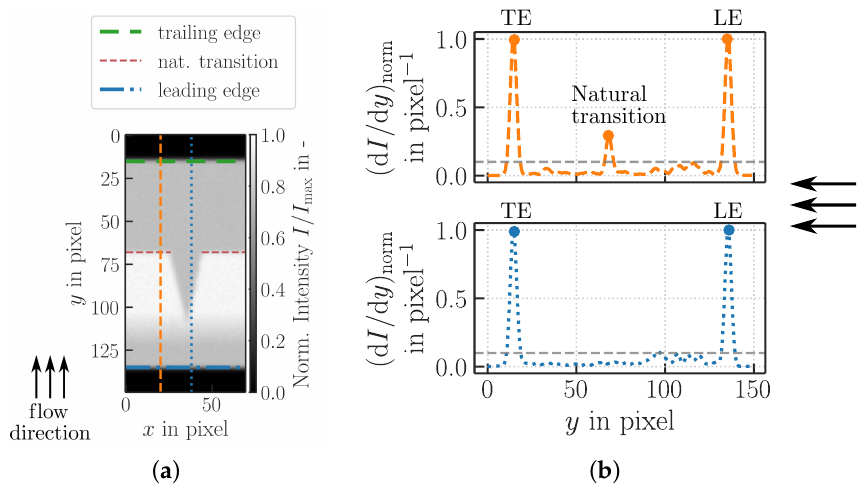
Figure 2. Simulated thermogram ( a ) and normalized gradient ( b ) for two chord-wise positions. The blue line intersects a turbulence wedge, which results in less pronounced maxima of the gradient below the threshold of 0.1pixel − 1 , marked with a dashed gray line. ( a ) Simulated thermogram with one turbulence wedge. The trailing edge is labeled with a green dashed line, the leading edge with a blue dash-dotted line. The natural transition is marked with a red dashed line, excluding premature transitions. The two vertical lines mark the positions for the intensity gradients, see ( b ). ( b ) Intensity gradients normalized by their respective maximums for the two lines at x orange = 20pixel ( top ) and x blue = 38pixel ( bottom ). Local maxima are marked with dots and correspond to the trailing edge (TE), the natural transition and the leading edge